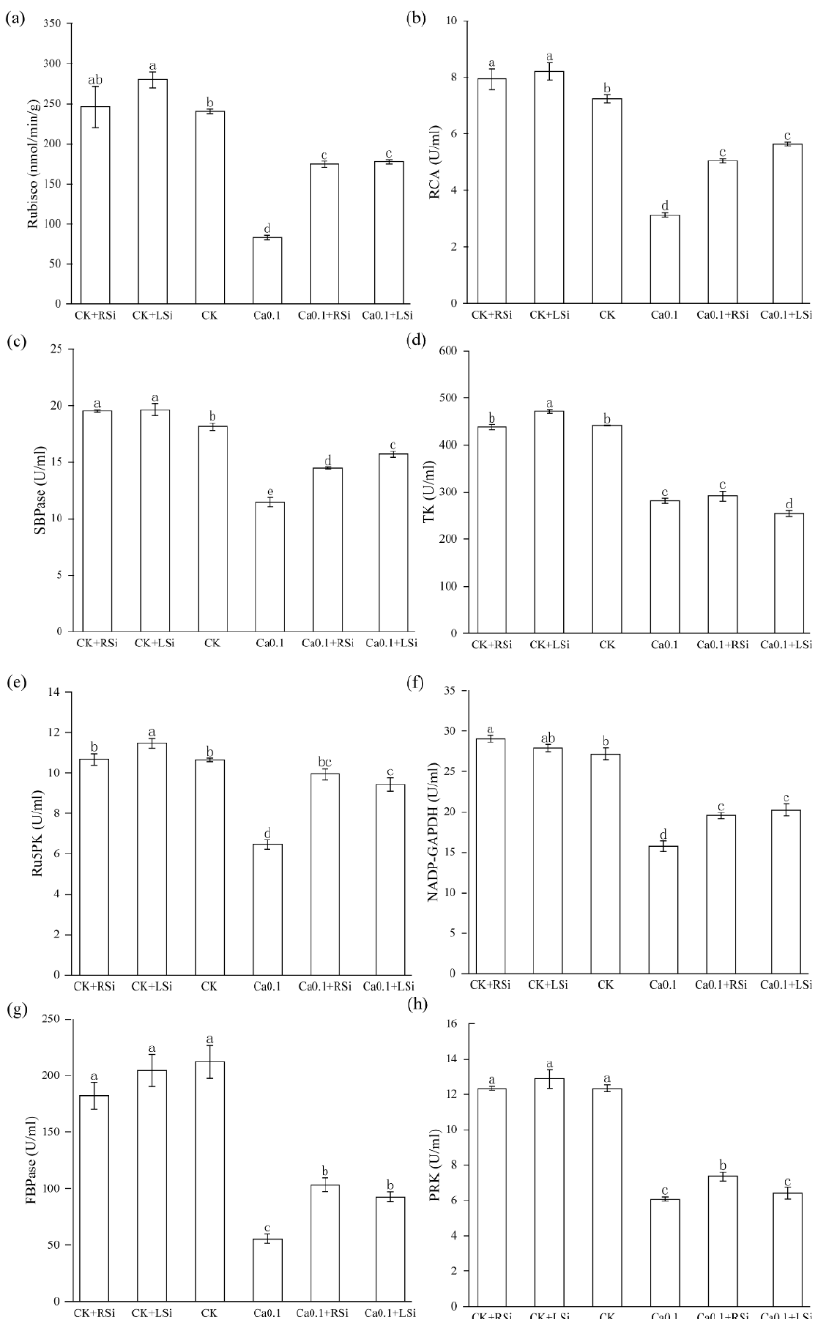
Figure 7. Effect of exogenous Si on the activity of enzymes related to photosynthesis in tomato plants under low − calcium stress. ( a ) RuBisco, ( b ) RCA, ( c ) SBPase, ( d ) TK, ( e ) Ru5PK, ( f ) NADP − GAPDH, ( g ) FBPase, ( h ) PRK. The means of three replicates ± standard error is shown. The data were subjected to an ANOVA test to determine the LSD, and bars superscribed by different letters are significantly different at p < 0.05. Standard errors are indicated by bars. CK + RSi: 4 mM Ca in Hoagland nutrient solution + root application of 1 mM Si; CK + LSi: 4 mM Ca in Hoagland nutrient solution + foliar application of 1 mM Si; CK: 4 mM Ca in Hoagland nutrient solution; 0.1Ca: 0.1 mM Ca in Hoagland nutrient solution; 0.1Ca + RSi: 0.1 mM Ca in Hoagland nutrient solution + root application of 1 mM Si; 0.1Ca + LSi: 0.1 mM Ca in Hoagland nutrient solution + foliar application of 1 mM Si.